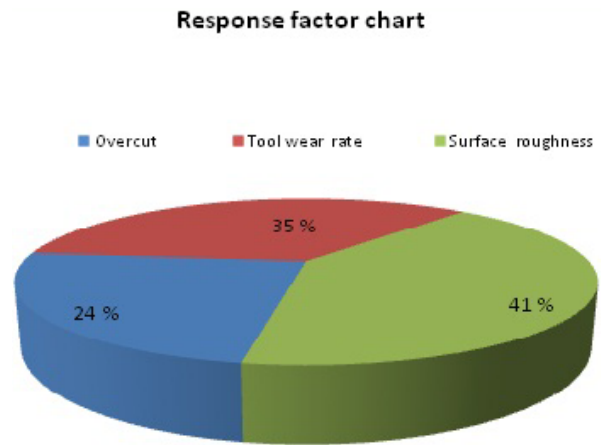
Figure 19. Response factor